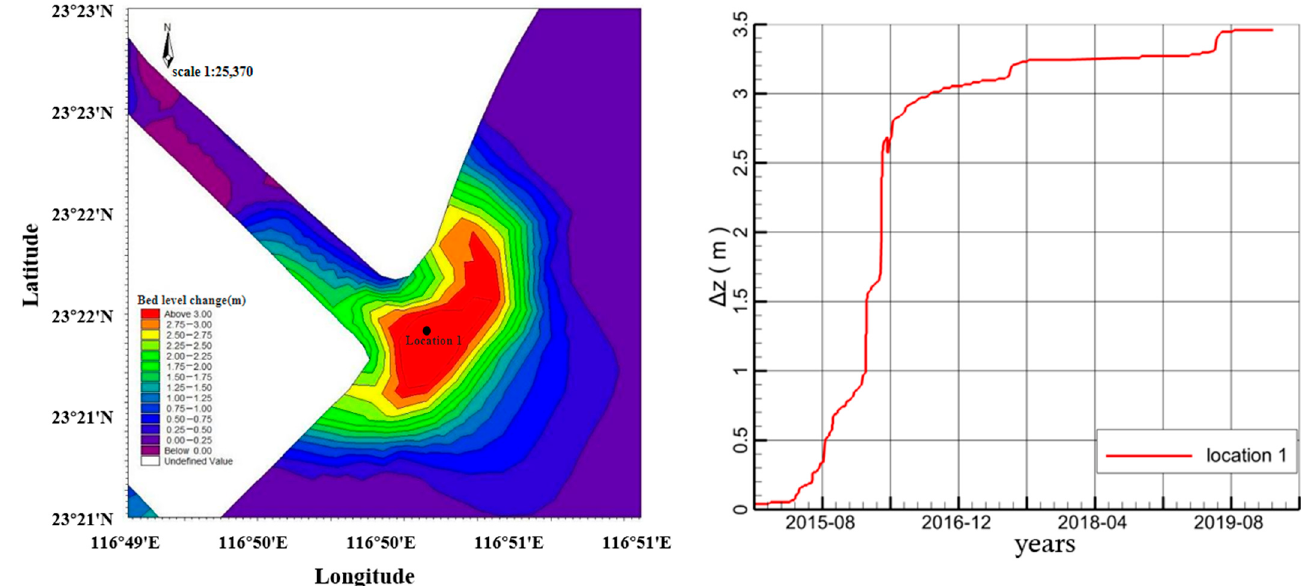
Figure 15. Changes of sedimentation thickness in Hanjiang Xixi Estuary in 5 years.